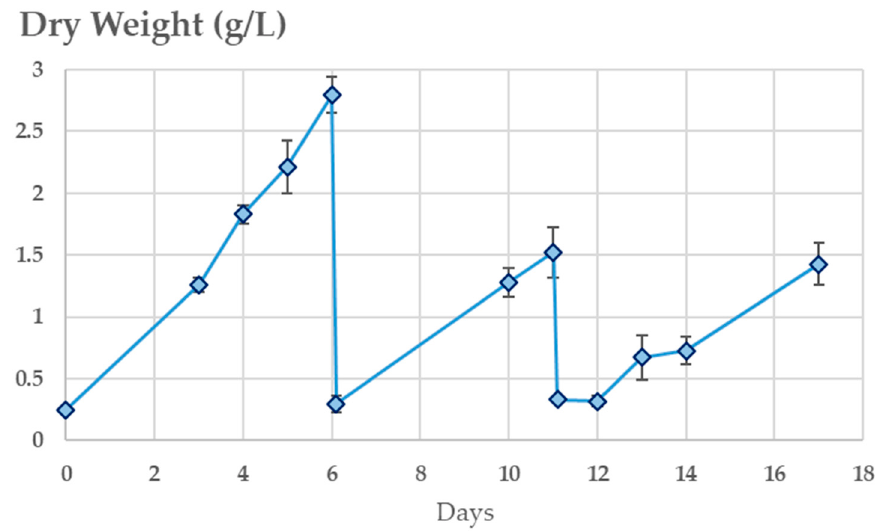
Figure 6. Dry weight (g/L) for HFWWC during the three cycles of continuous treatment of HFWW (triplicates).